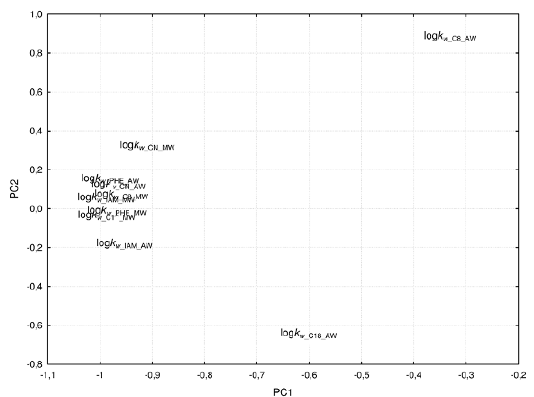
Figure 3. Loading plot for PC1 and PC2.